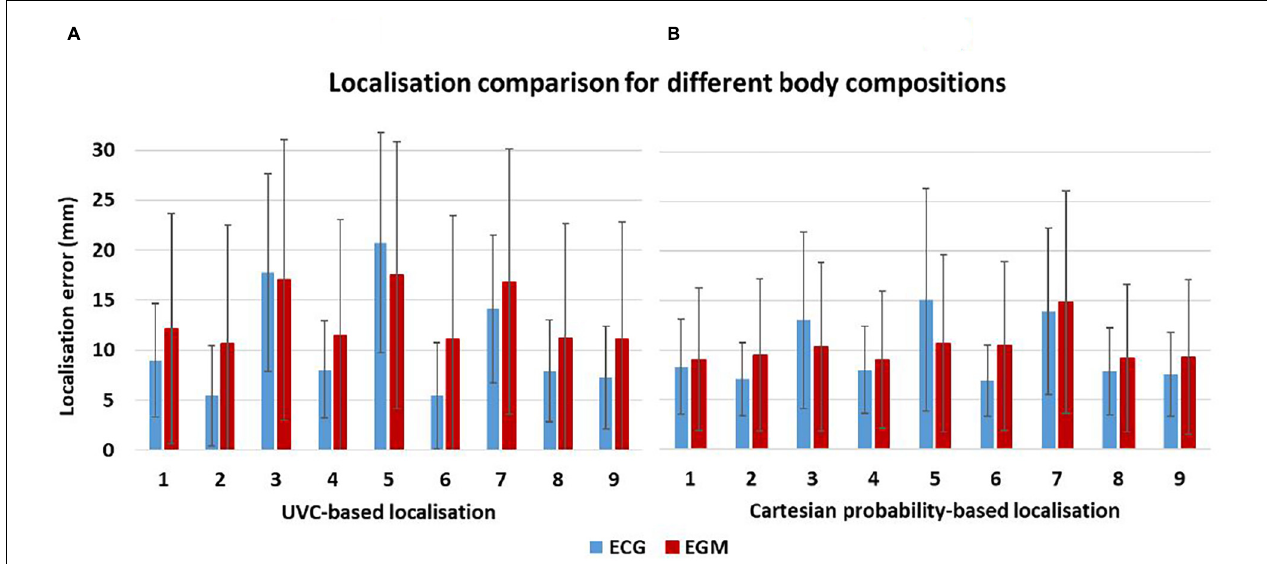
FIGURE 13 | Localization sensitivity to tissue conductivities. Mean localization errors are here reported for UVC-based (A) and Cartesian probability-based (B) localization as different organ conductivities were changed in the torso model—see Table 2 . Small differences are seen between ECG-based (red) and EGM-based (blue) localization